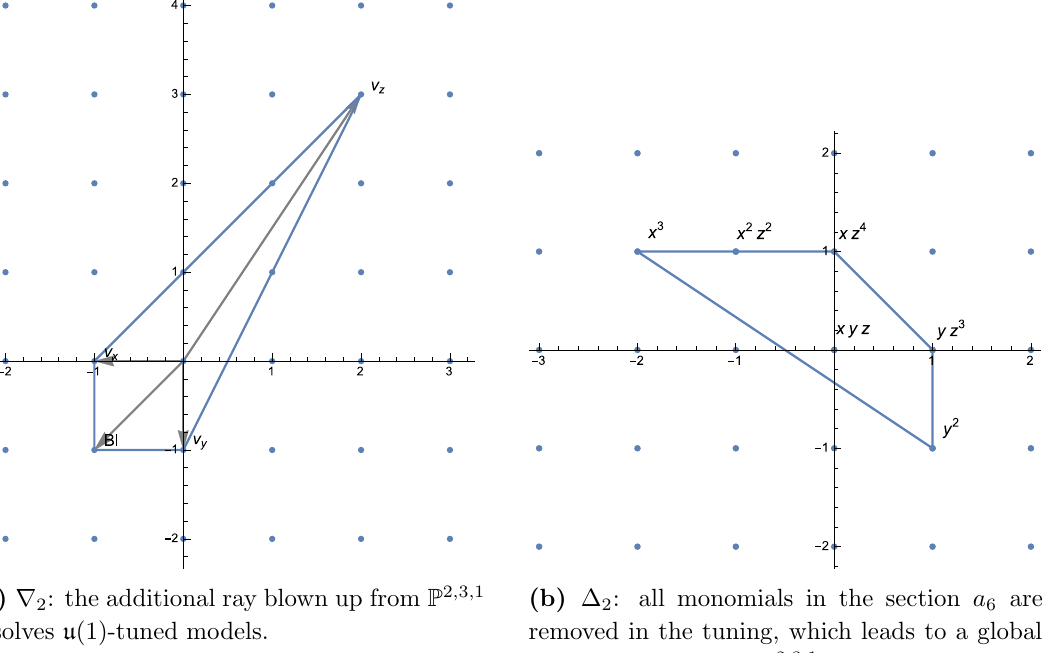
P 2 ; 3 ; 1 ambient toric [0 ; 0 ; 1]